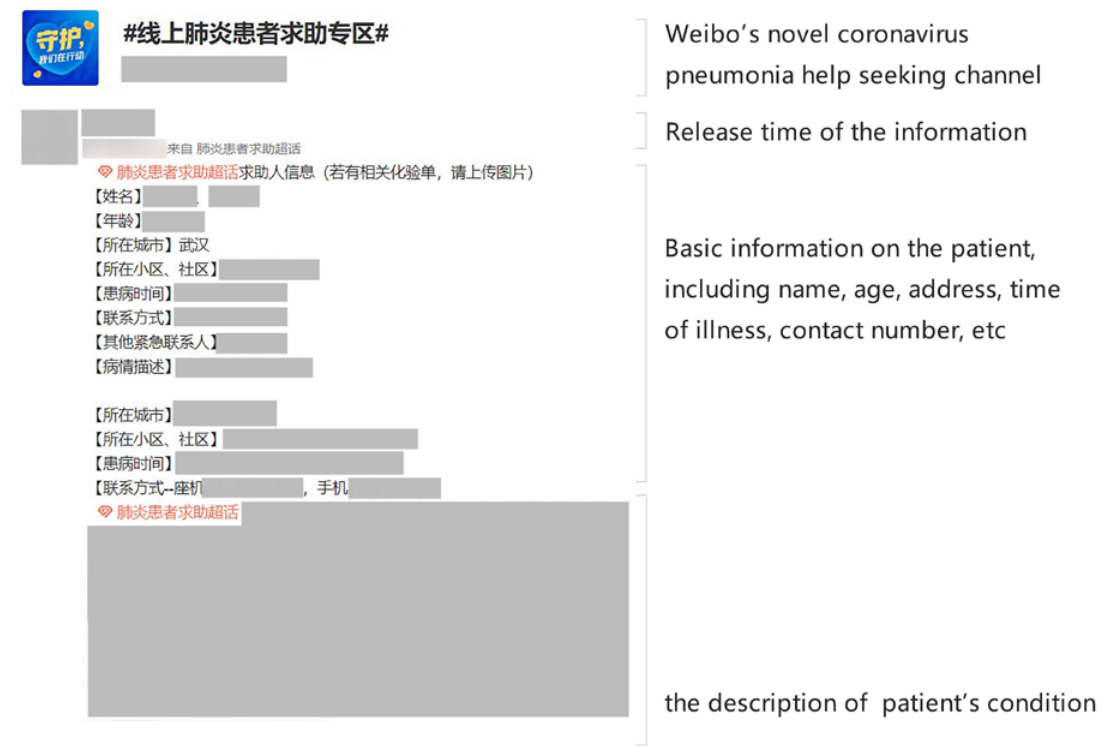
Figure 4. An example of Weibo help-seeking information.